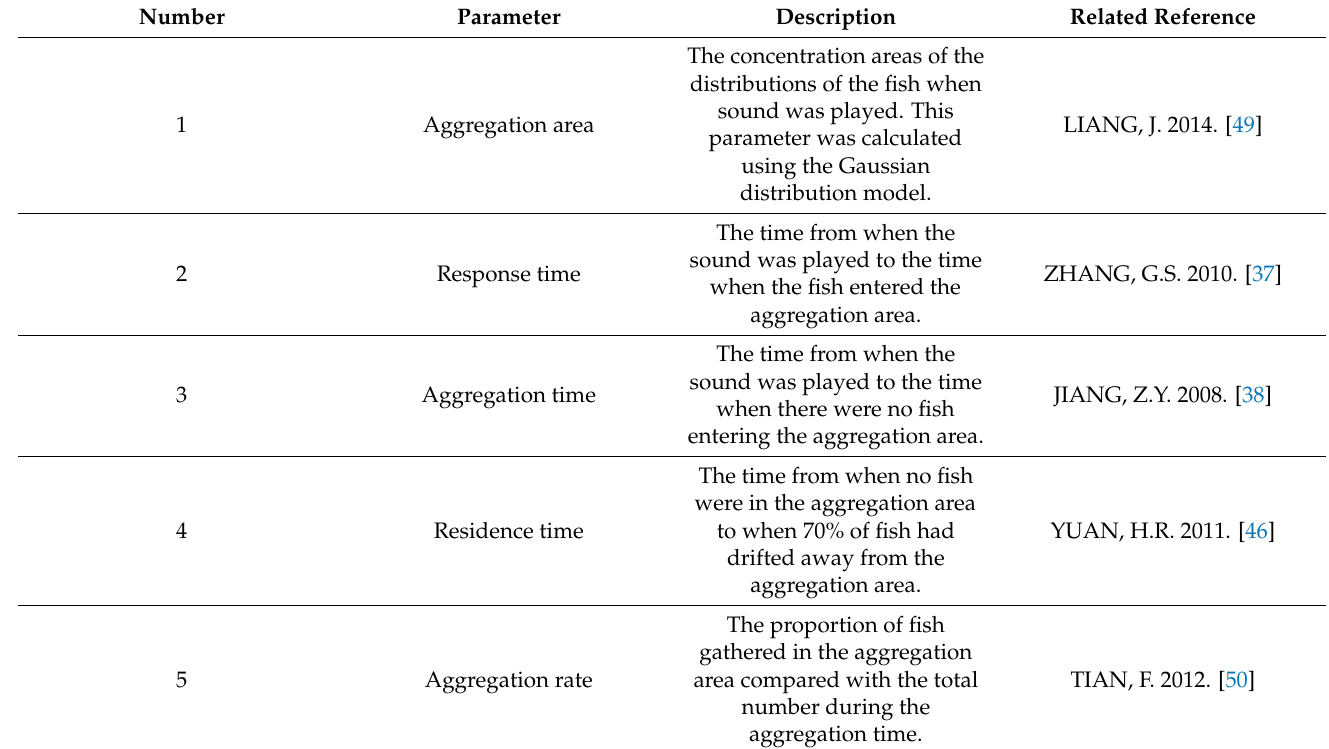
Table 1. Description of the measured